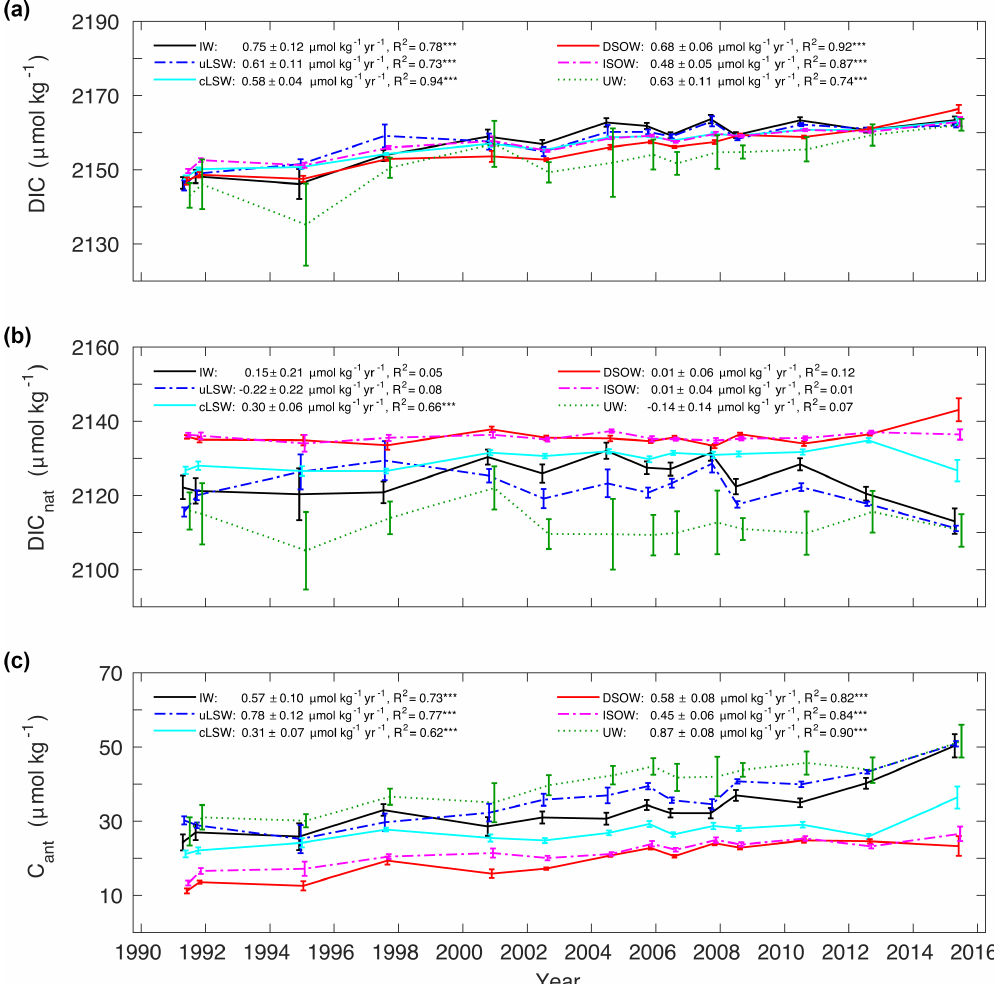
Figure 8. Archetypal concentration for IW, uLSW, cLSW, DSOW, ISOW and the sum over the upper ocean waters (UWs) in the Irminger Sea from 1991 to 2015 for (a) DIC, (b) DIC nat and (c) C ant . The error bars represent σ . The storage rates between 1991 and 2015 are given for all SWTs, including the R-squared value of the linear regression model. Significance at the 90% level ( ∗ ) or the 99% level ( ∗∗∗ ) is indicated. Values of the two cruises in 1997 were averaged and are shown as one data point. All markers are slightly offset in time for